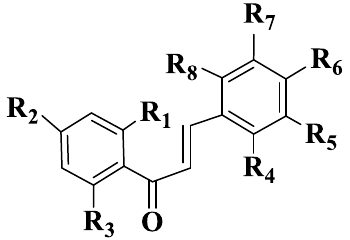
Figure 3. General structure of chalcones 14 – 47 .